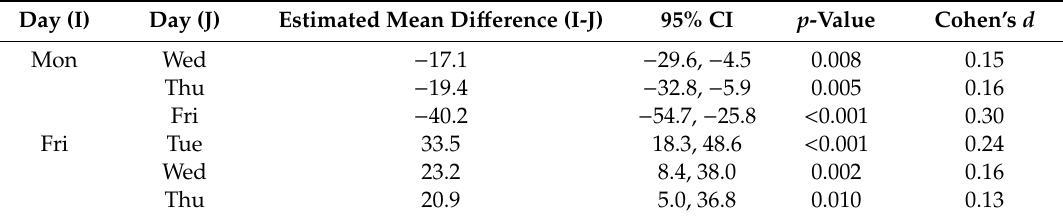
Table A5. Pairwise comparisons of significant estimated mean di ff erences in LPA (min) between weekdays A .